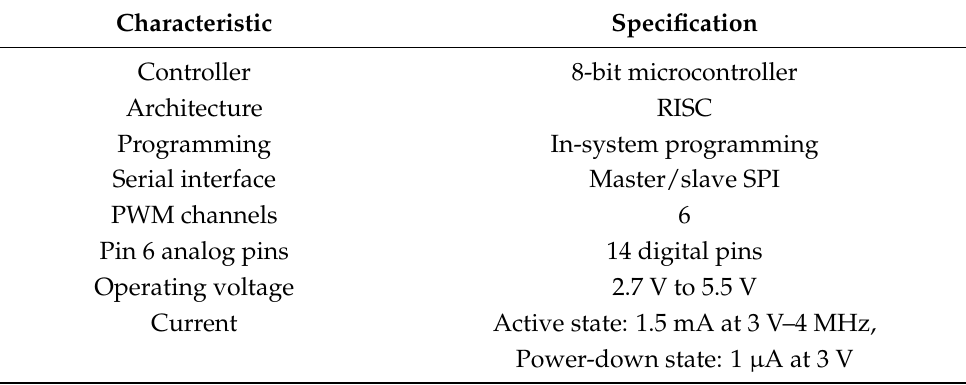
Table 2. Atmega328P specifications [36].